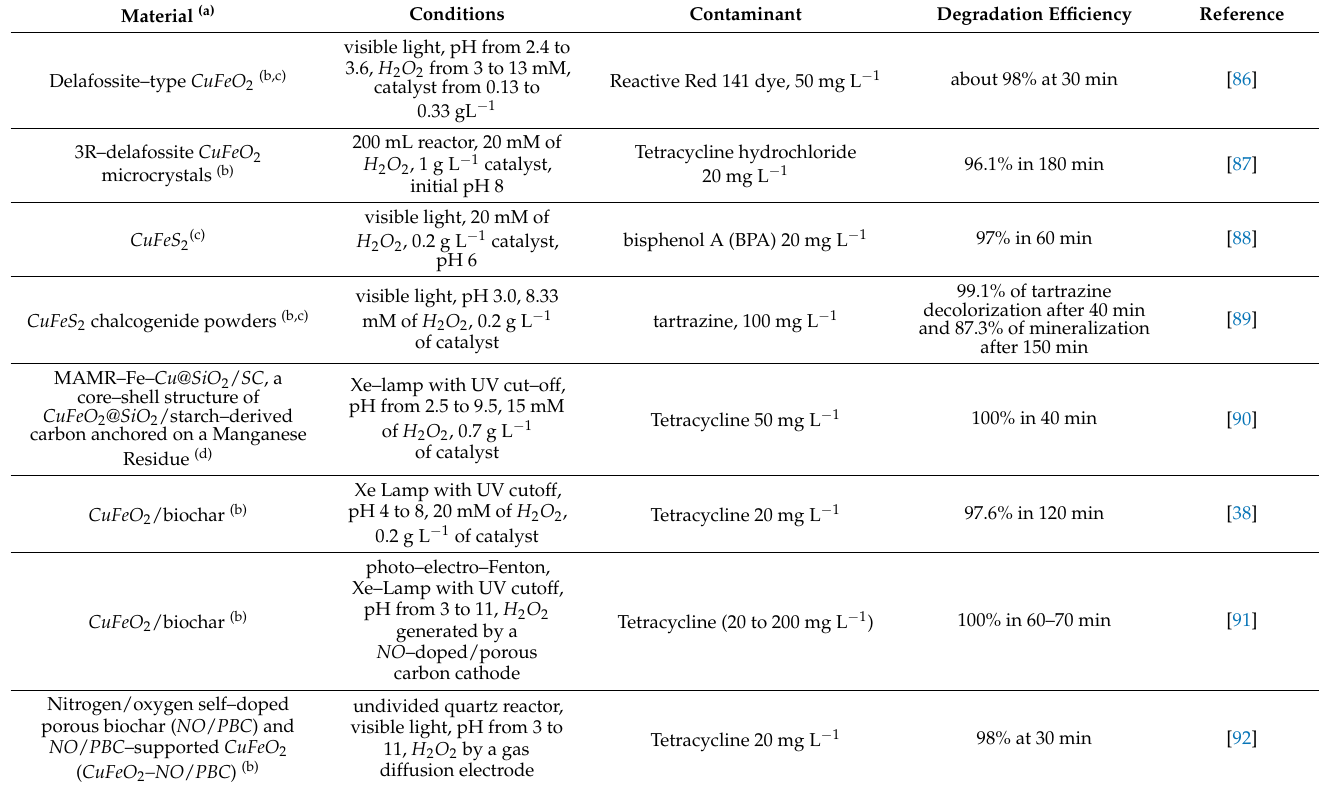
Table 2. Summary of recently used CuFeO 2 and CuFeS 2 as photo–Fenton photocatalysts in wastewa- ter